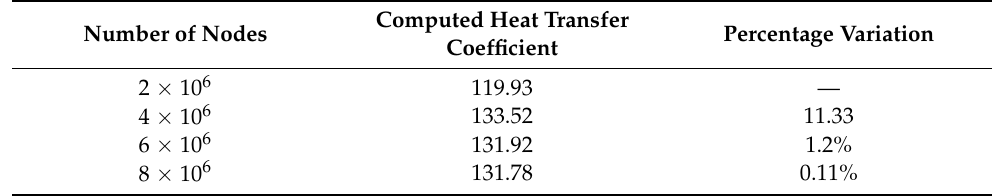
Table 2. Grid sensitivity analyses.